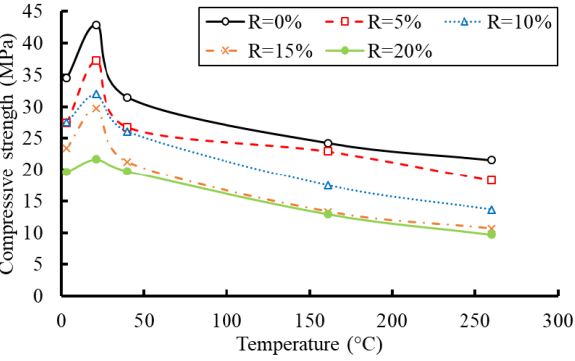
Figure 18. Effect of temperature on concrete with different percentages of CR.